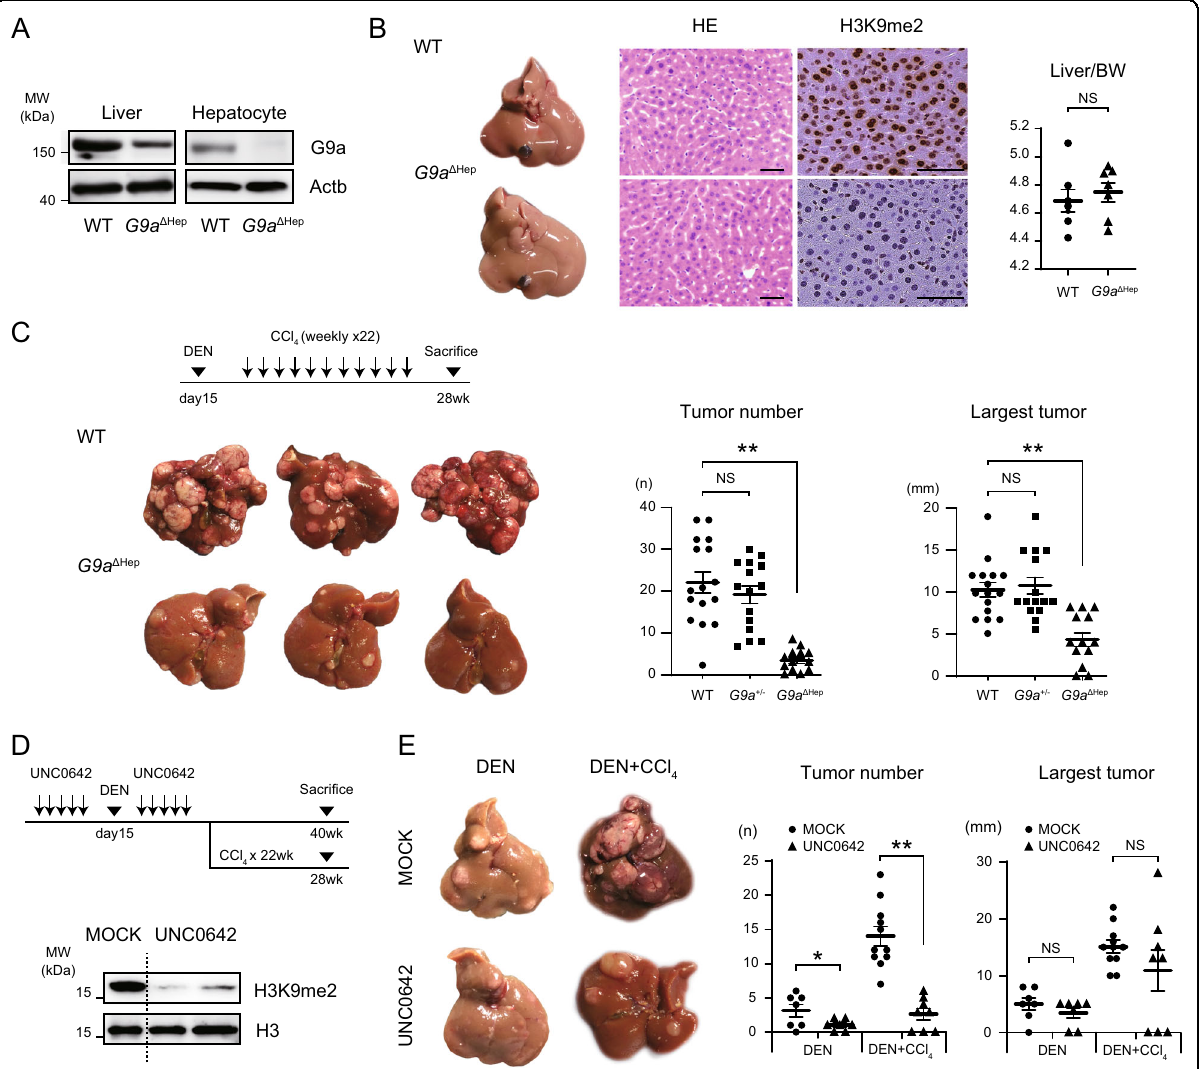
Fig. 2 G9a inhibition attenuates DEN-induced hepatocarcinogenesis. A G9a deletion is con fi rmed using immunoblotting of liver lysates and isolated primary hepatocytes. B Representative macro- and micro-images of the liver and liver/body weight (BW) ratio of 30-week-old mice. There is no obvious difference between wild-type (WT) and G9a Δ Hep livers, but H3K9me2 levels are markedly attenuated in the G9a Δ Hep hepatocytes. Scale bars, 50 µm; each, n = 7; NS not signi fi cant, Student ’ s t test. C WT and G9a Δ Hep mice are subjected to diethylnitrosamine (DEN) (25 mg/kg i.p.) at day 15 postpartum, followed by 22 injections of carbon tetrachloride (CCl 4 ) (0.5. mL/kg i.p.) per week and euthanized 6.5 months after DEN administration. Liver tumor development is signi fi cantly attenuated in G9a Δ Hep mice (WT, n = 16; G9a + / − , n = 15; G9a Δ Hep , n = 13; ** p < 0.01, NS not signi fi cant, Student ’ s t test). D Immunoblots using liver lysates after fi ve sequential days of UNC0642 injection reveal that G9a inhibitor successfully reduces H3K9me2 levels in the liver. E UNC0642 treatment signi fi cantly attenuates DEN-induced liver tumor development (DEN/MOCK, n = 7; DEN/ UNC0642, n = 7; DEN + CCl 4 /MOCK, n = 11; DEN + CCl 4 /UNC0642, n = 8; * p < 0.05, ** p < 0.01, NS not signi fi cant, Student ’ s t